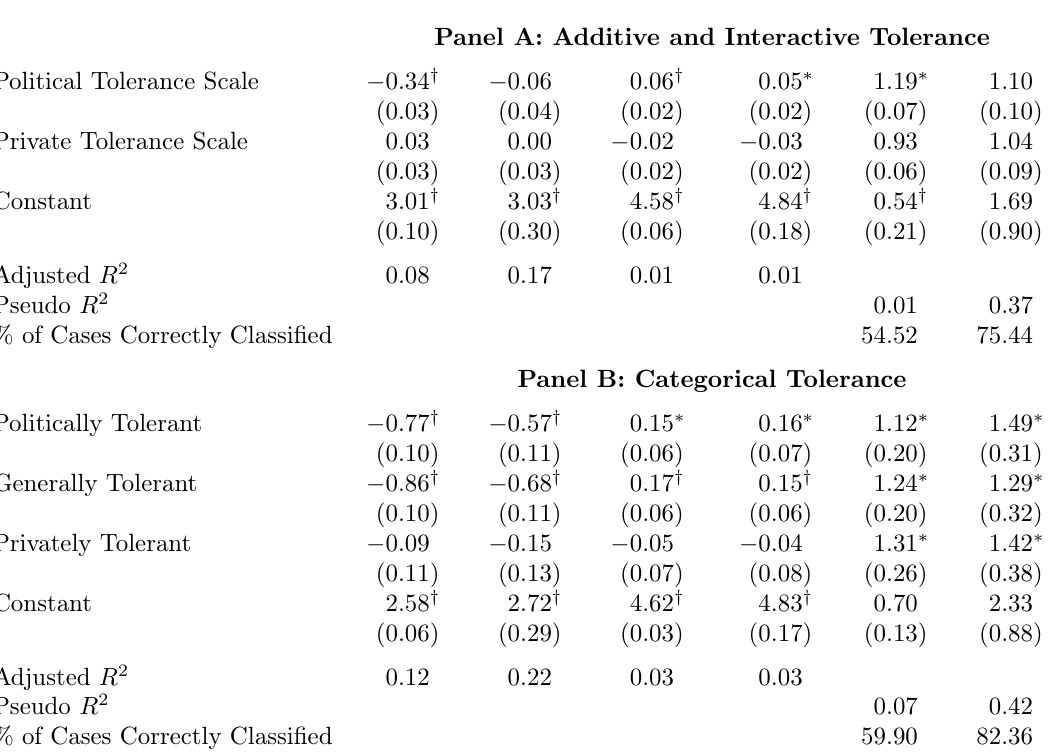
Table 8: Using Different Tolerance Measures to Estimate Various Outcomes Oppose Extreme All Are Entitled To Voted for Political Ideologies Legal Protections Obama in 08 (OLS Regression) (OLS Regression) (Logistic Regr.)